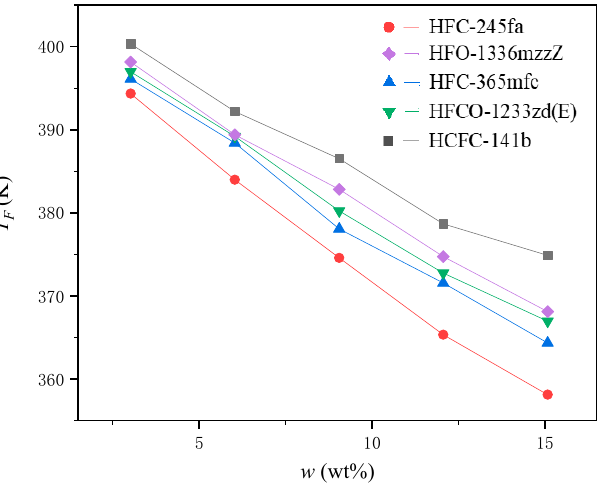
Figure 6. The relationship between the internal temperature of the foam when it stops expanding during polyurethane foaming, T F , and the initial mass ratio of the PBA to the other blending materials in the PURF, w